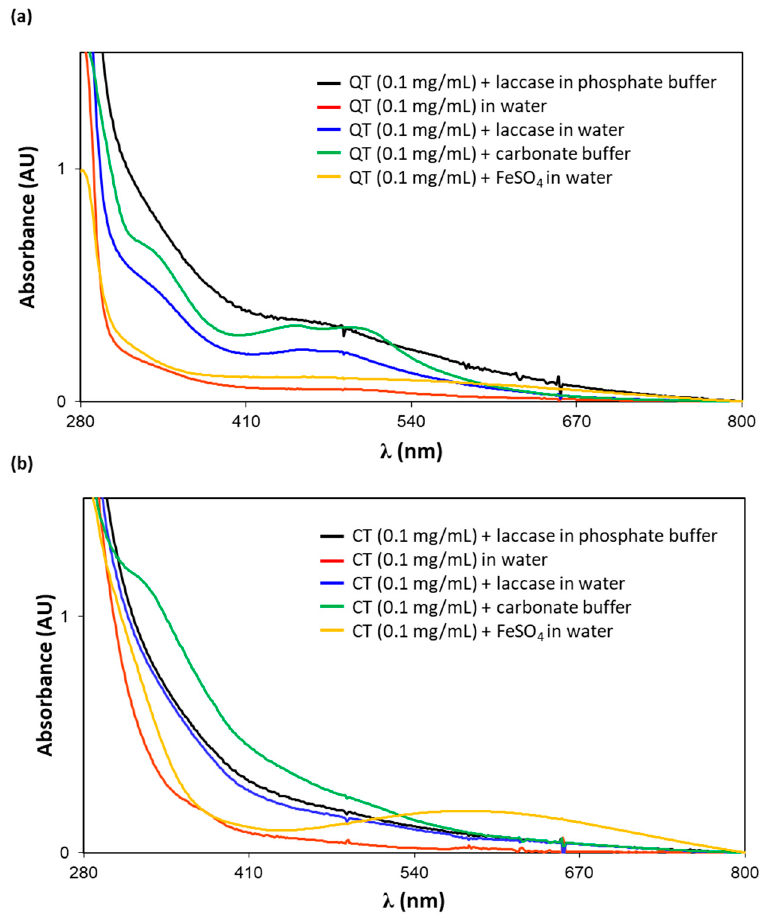
Figure 6. UV-vis spectra of the dip coating solutions at 2 h. ( a ) QT; ( b ) CT.